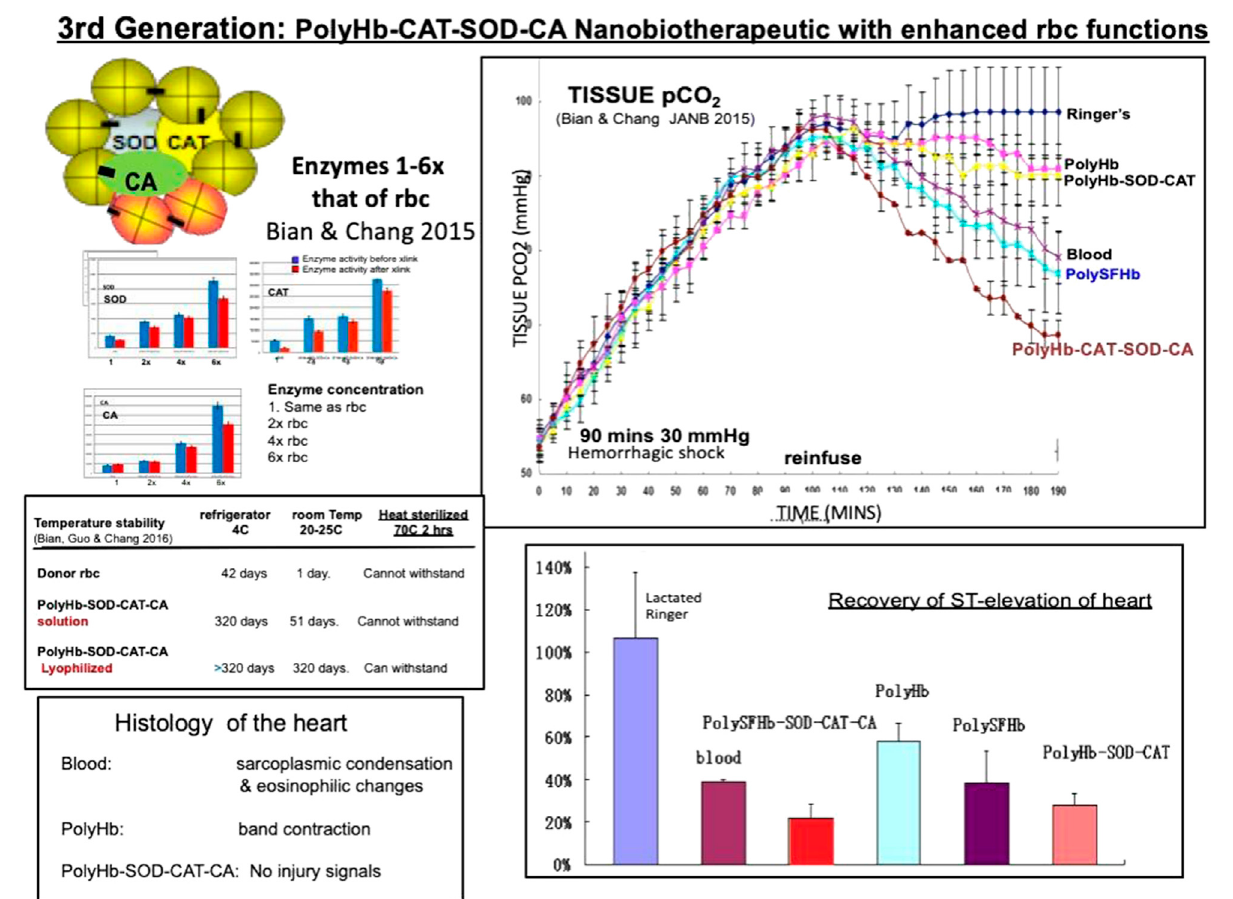
FIGURE 1 Left: PolyHb-CAT-SOD-CA with up to 6x enzyme enhancement and enzyme stability. Upper right: In a 90 min hemorrhagic shock animal model with 2/3 blood volume loss, it is superior to PolyHb and whole blood in the lowering of elevated intracellular pCO 2 . Lower right:recoveryof ST elevation. Lower left: histology of the heart (From Chang 2022 with written copyright permission to reproduce this fi gure from the publisher Taylor and